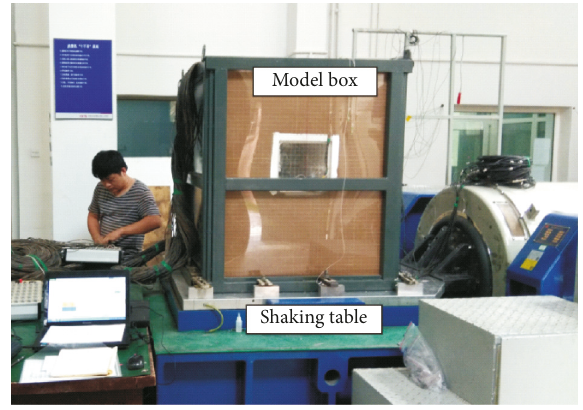
Figure 1: Shaking table system and the soil